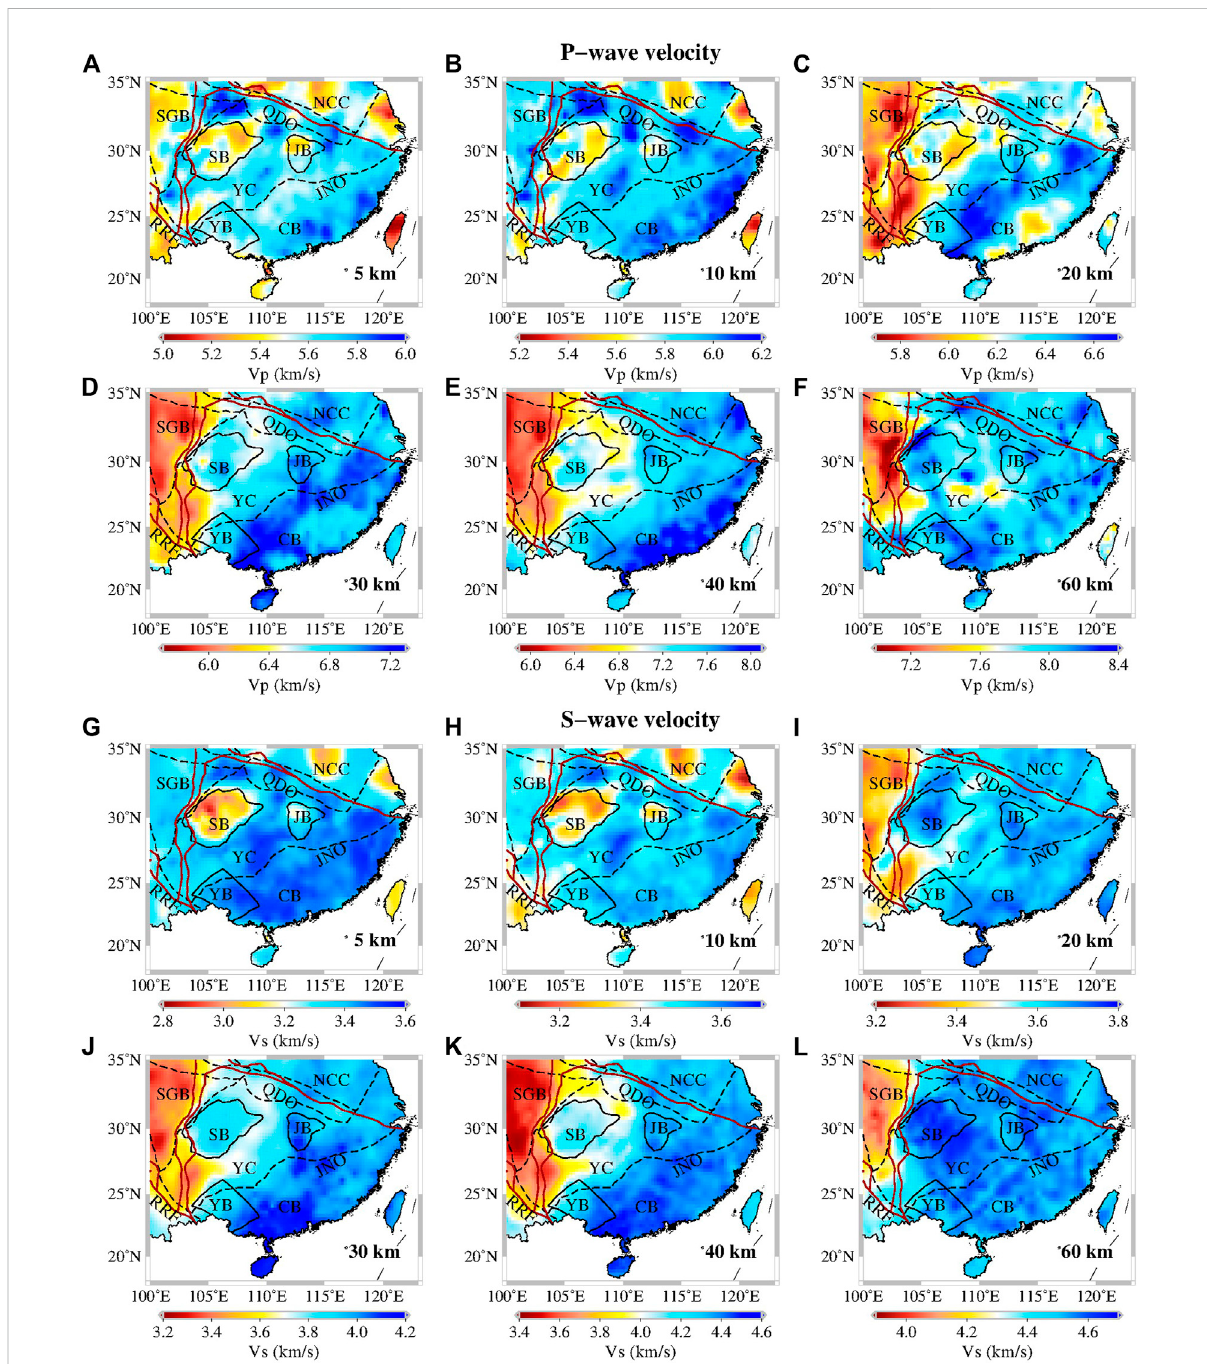
P-wave velocity distribution for the crustal and uppermost mantle component of SREM-SC at depths of (A) 5 km, (B) 10 km, (C) 20 km, (D) 30 km, (E) 40 km, and (F) 60 km. S-wave velocity distribution for the crustal and uppermost mantle component of SREM-SC at depths